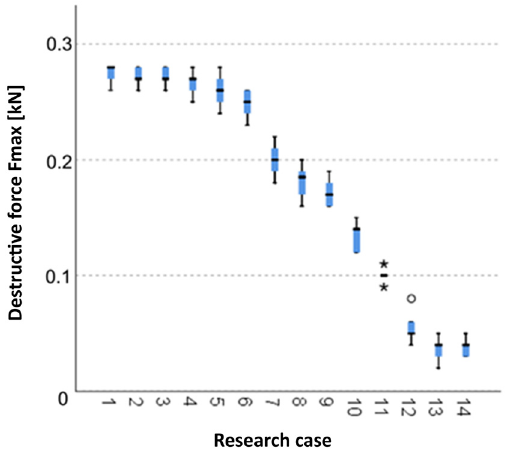
Figure 28. Kruskal–Wallis test results for independent tests of the F max break force.